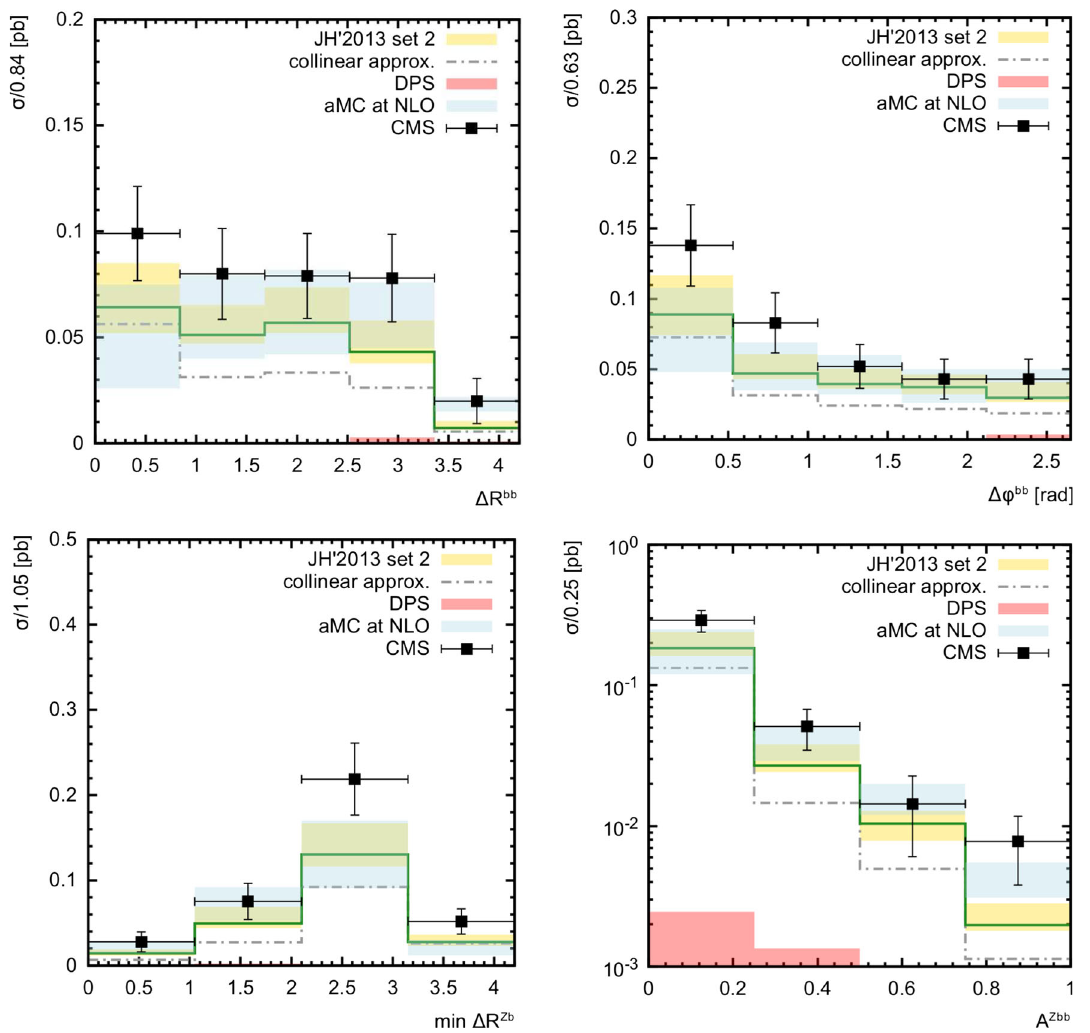
√ s = 7 TeV under additional kinematical cut on the Z -boson transverse